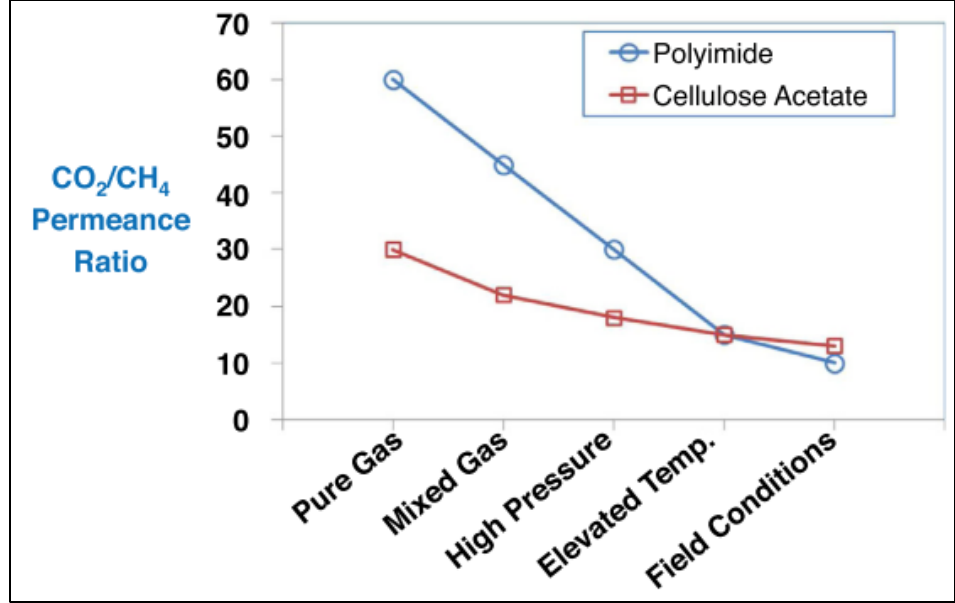
Figure 11. Illustration of PI (Polyimide) and CA (Cellulpse Acetate) membrane trend going from pure gas testing to the field conditions testing results [26].